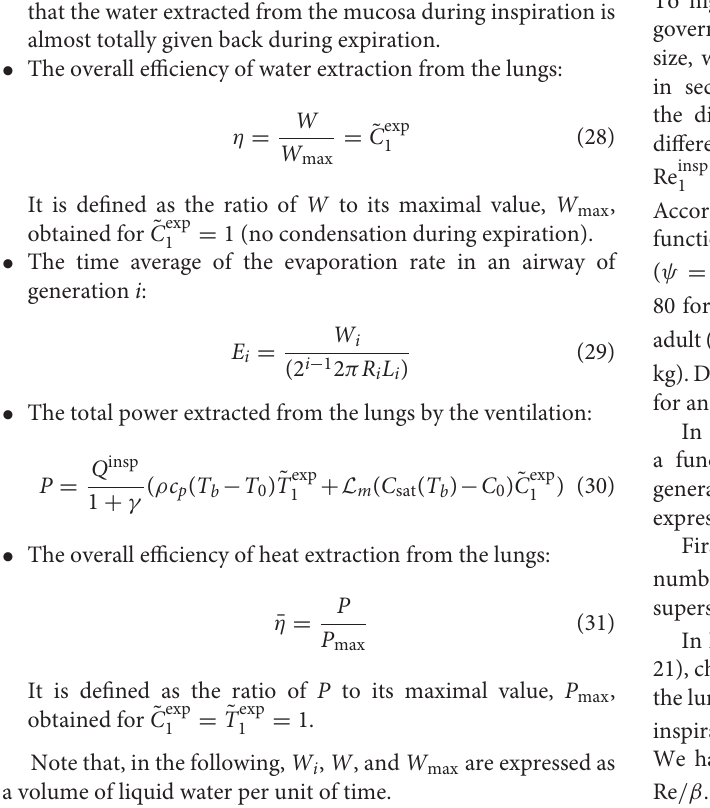
1 means ≃ 0 means ≃